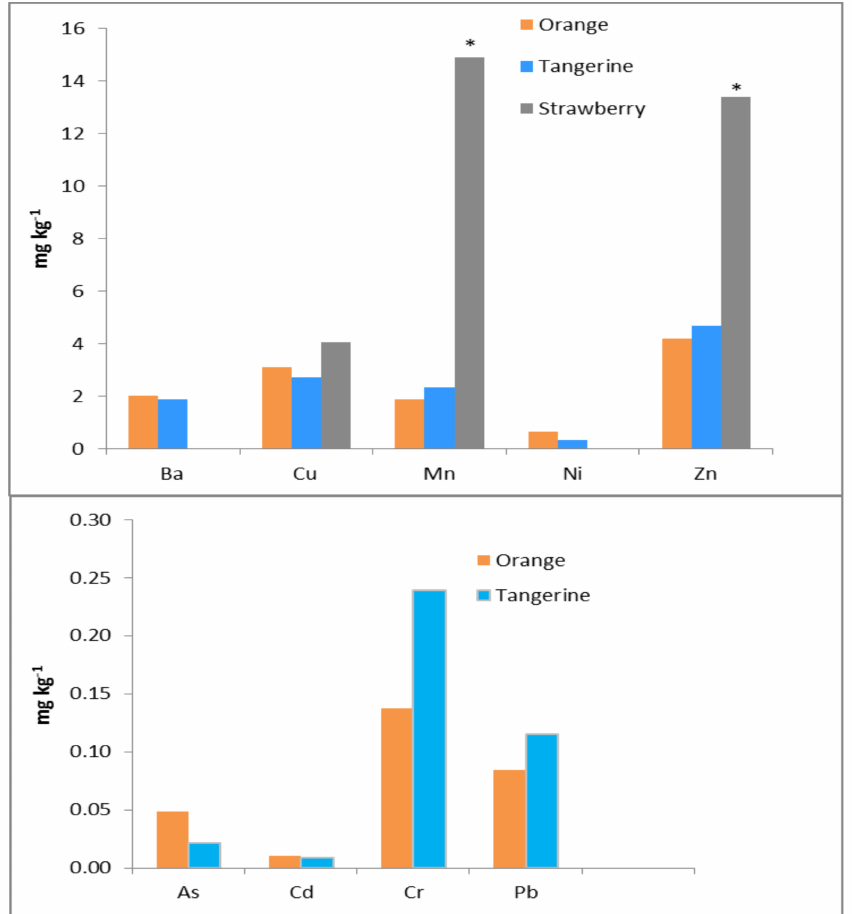
Figure 3. Element accumulation (mean value) in strawberry from urban gardens of Seville and orange and tangerine from urban garden of Rio Tinto mining area. Asterisk indicates statistical differences among